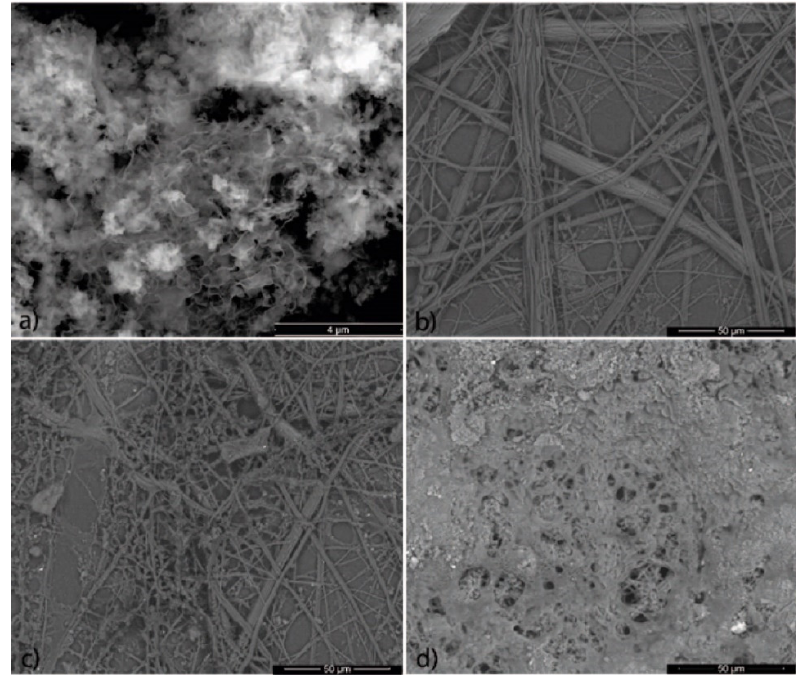
Figure 2. SEM images of a ) exfoliated g-C 3 N 4 (ECN) and the modified b ) S1, c ) S2 and d ) S6 fabrics.